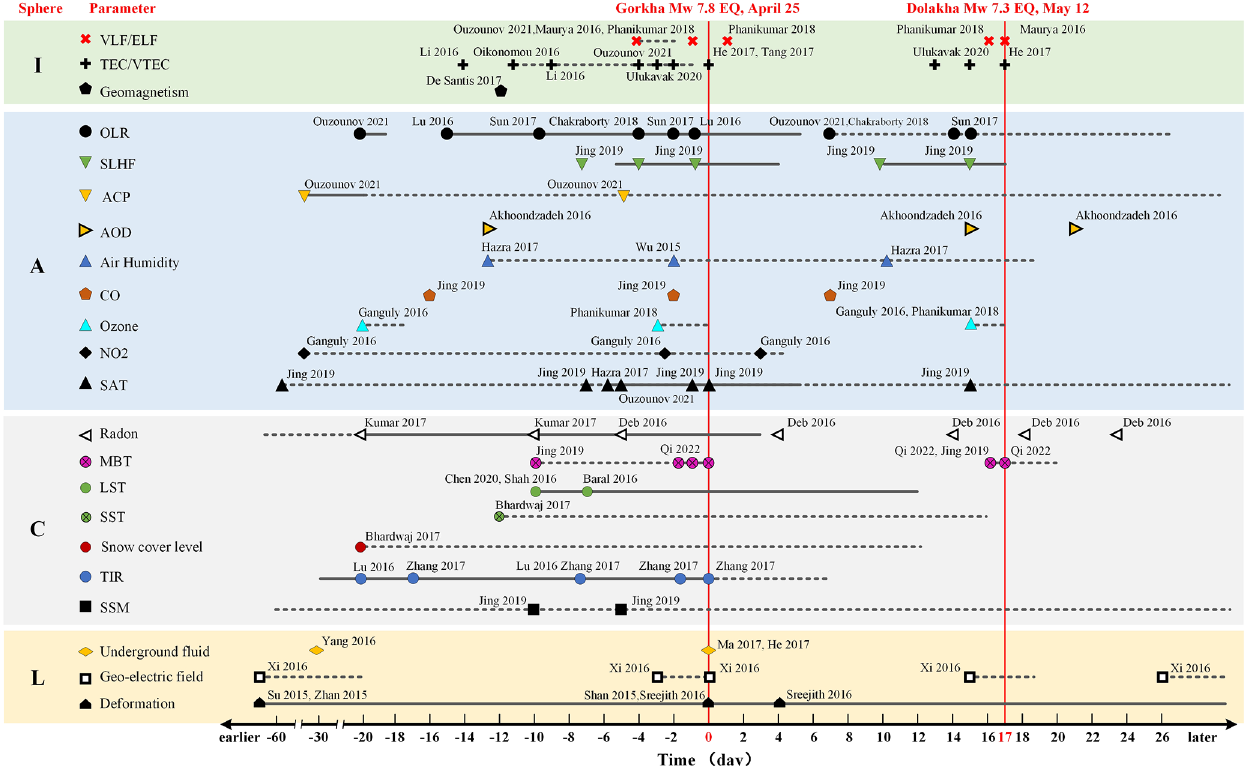
Figure 3. The temporal distribution of multiple anomalies from the lithosphere up to the ionosphere before, during, and after the Gorkha earthquake and Dolakha earthquake in 2015. The dotted icon indicates that the anomaly occurred on a particular day, the solid line means the anomaly was persistent, while the dashed line means that the anomaly was fluctuant or